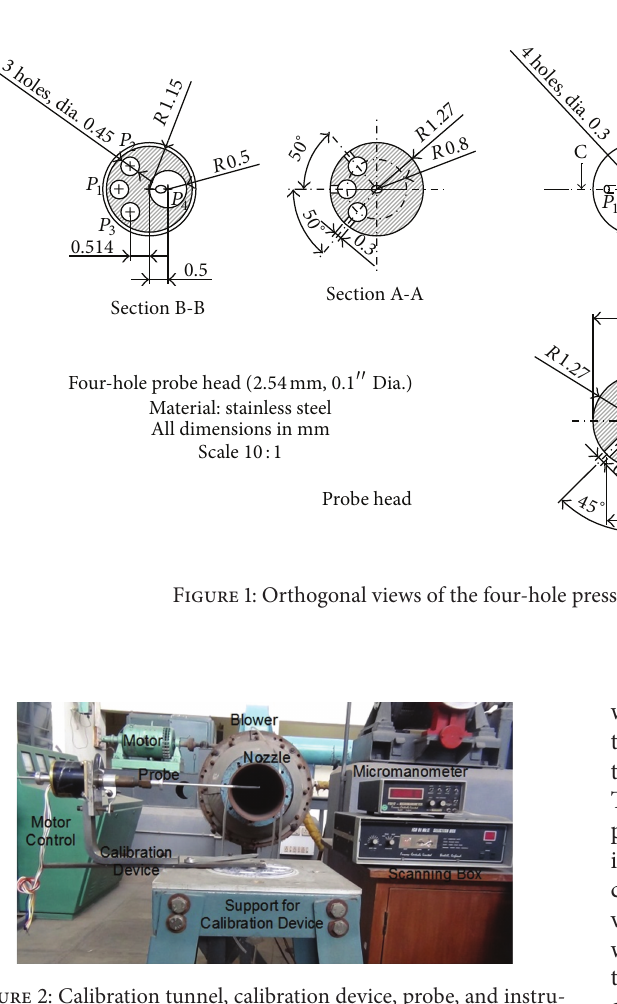
Figure 2: Calibration tunnel, calibration device, probe, and instru-